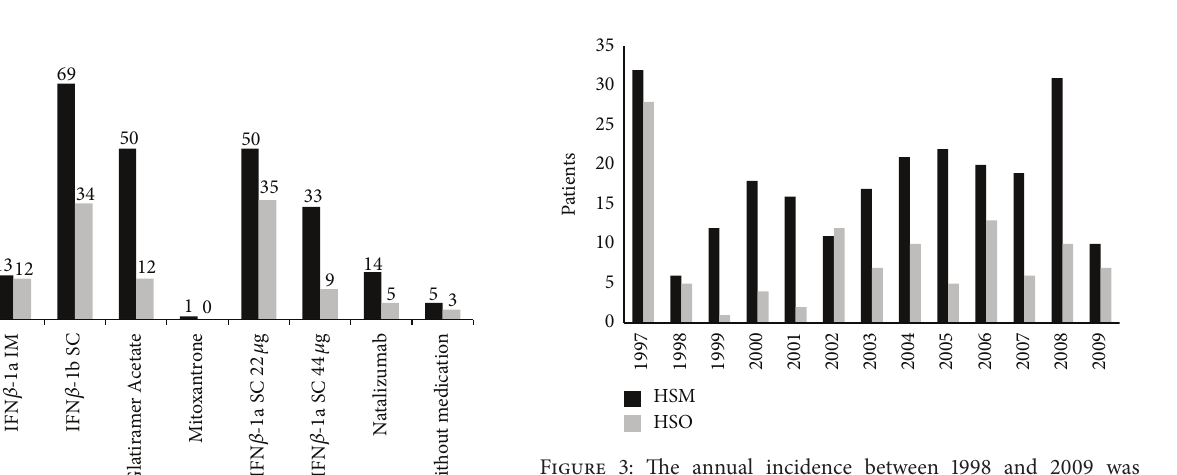
Figure 3: The annual incidence between 1998 and 2009 was